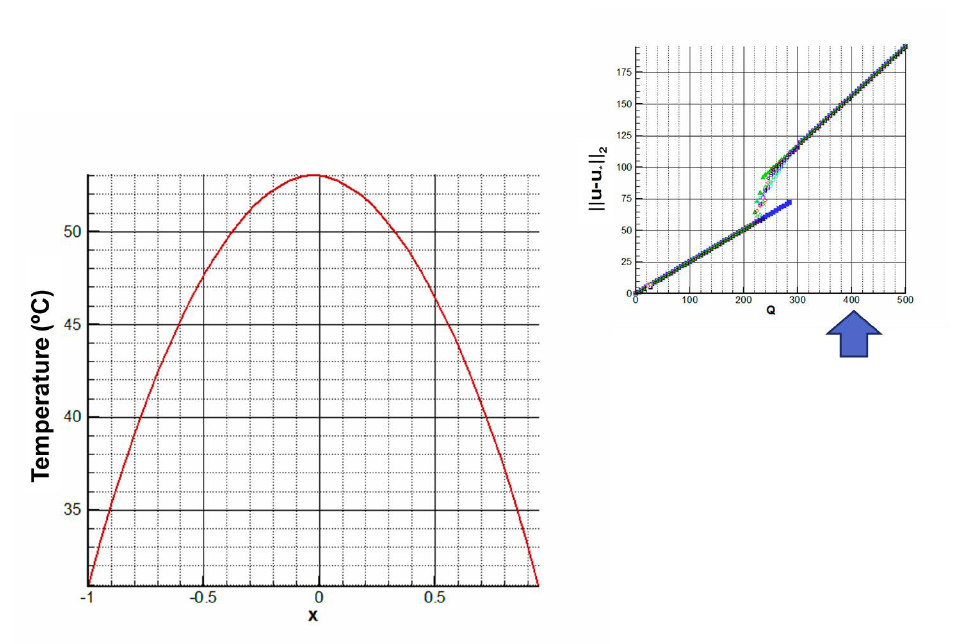
Figure 11. Unique stationary solution. Coupled model. Q = 400.